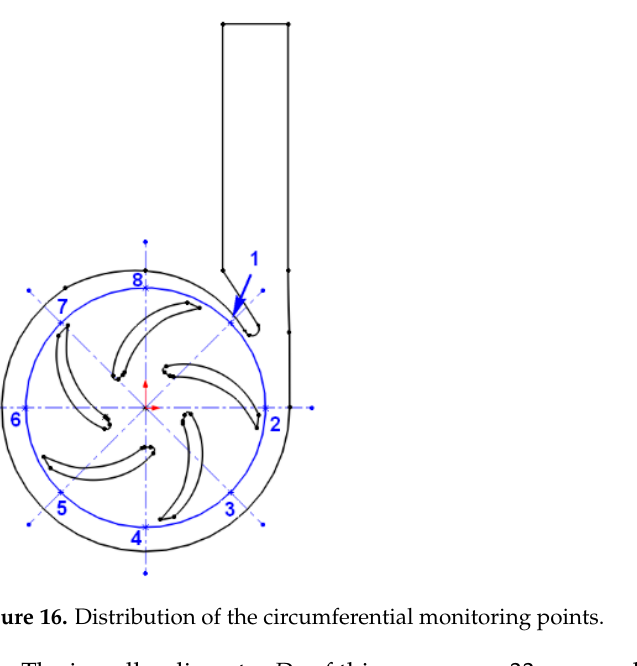
Figure 16. Distribution of the circumferential monitoring points.